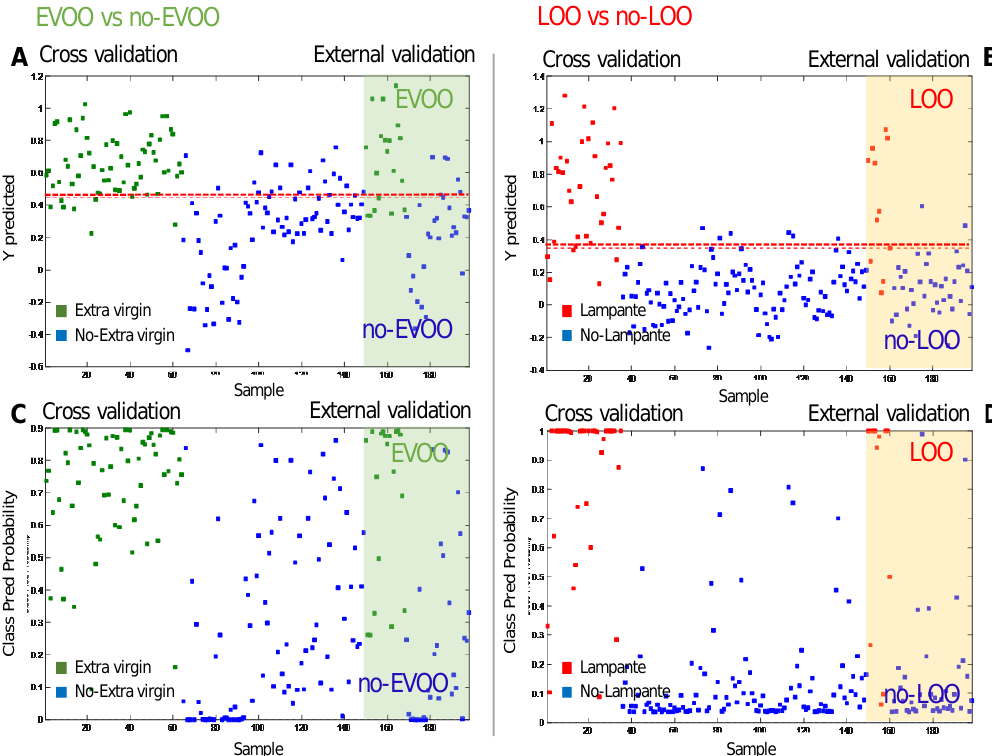
Figure 3. Graphical results obtained from 2 of the 4 partial least squares—discriminant analysis (PLS–DA) models for prediction of quality grade of virgin olive oils (VOOs). ( A , B ): values of the estimated Y variable by the model, extra virgin olive oil (EVOO) vs. no-EVOO ( A ) and lampante olive oil (LOO) vs. no-LOO ( B ), in cross and external validation. ( C , D ): values of the class prediction probability by the model, EVOO vs. no-EVOO ( C ) and LOO vs. no-LOO ( D ), in cross and external validation. Table 2. Percentages of correctly classified samples by the 4 PLS–DA models for the quality grade